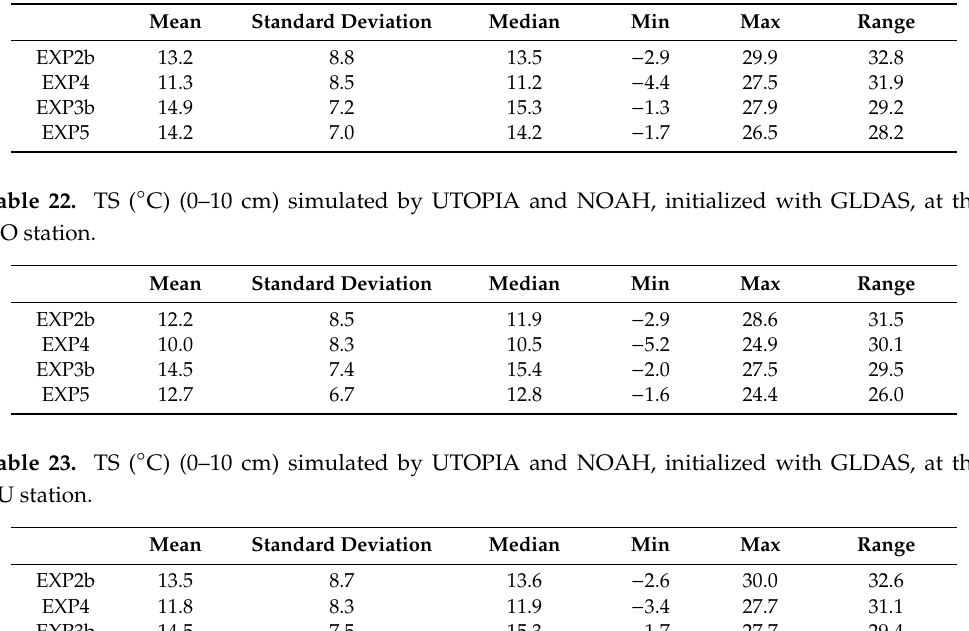
Table 21. TS ( ◦ C) (0–10 cm) simulated by UTOPIA and NOAH, initialized with GLDAS, at the CF station.